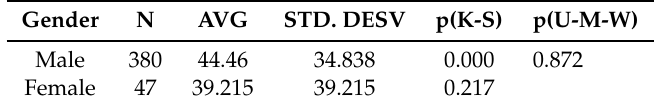
Table 6. Study of the degree of progress in lab